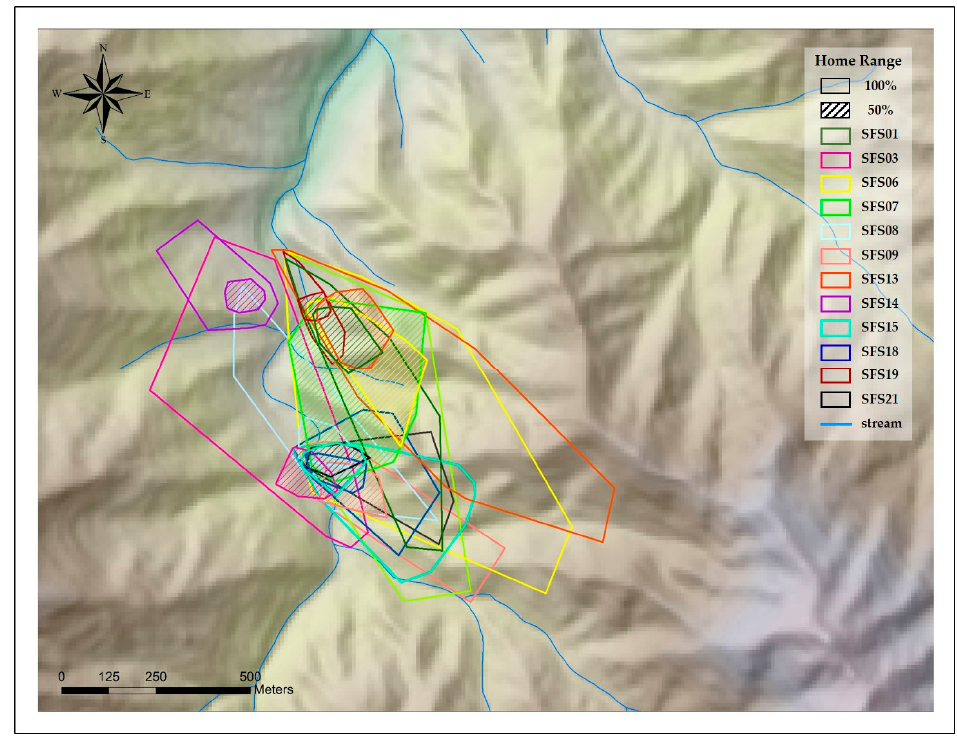
Figure 2. Home range size and core area of Siberian flying squirrels at Mt. Baekwoon, Gangwon Province, South Korea, based on the minimum convex polygon (MCP). Animals 2020 , 10 , x FOR PEER REVIEW